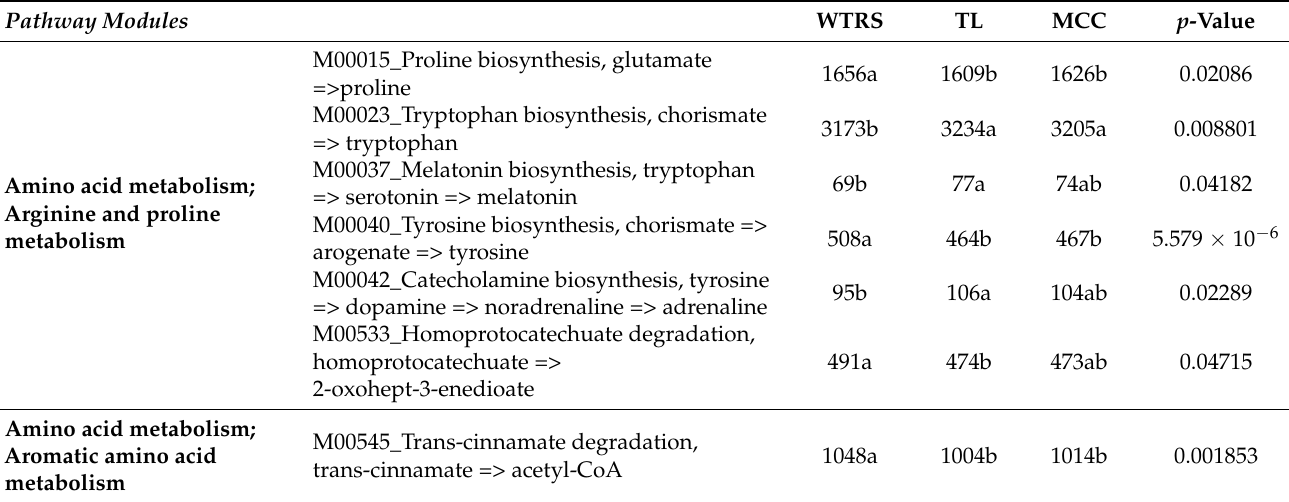
Table 2. Functional units of gene sets in metabolic pathways (KEGG modules) of tomato rhizosphere soils differentially represented among tomato varieties. Different letters indicate a significant difference among tomato varieties (ANOVA, Dunn’s post hoc-Bonferroni corrected p values). WTRS: wild tomato related species; TL: tomato landraces; MCC: modern commercial